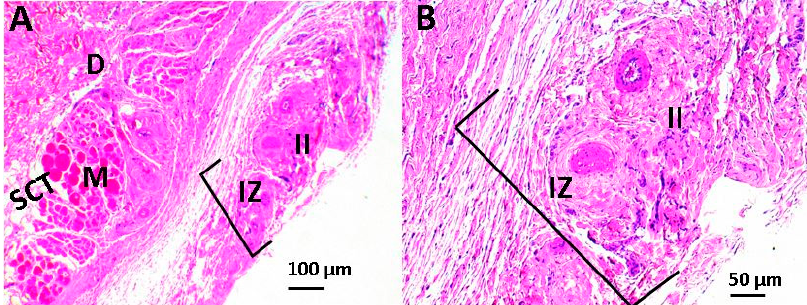
Figure 9. Scaffold with 0.5% GO using the hematoxylin and eosin technique. Image ( A ) at 4× and Figure 9. Sca ff old with 0.5% GO using the hematoxylin and eosin technique. Image ( A ) at 4 × and